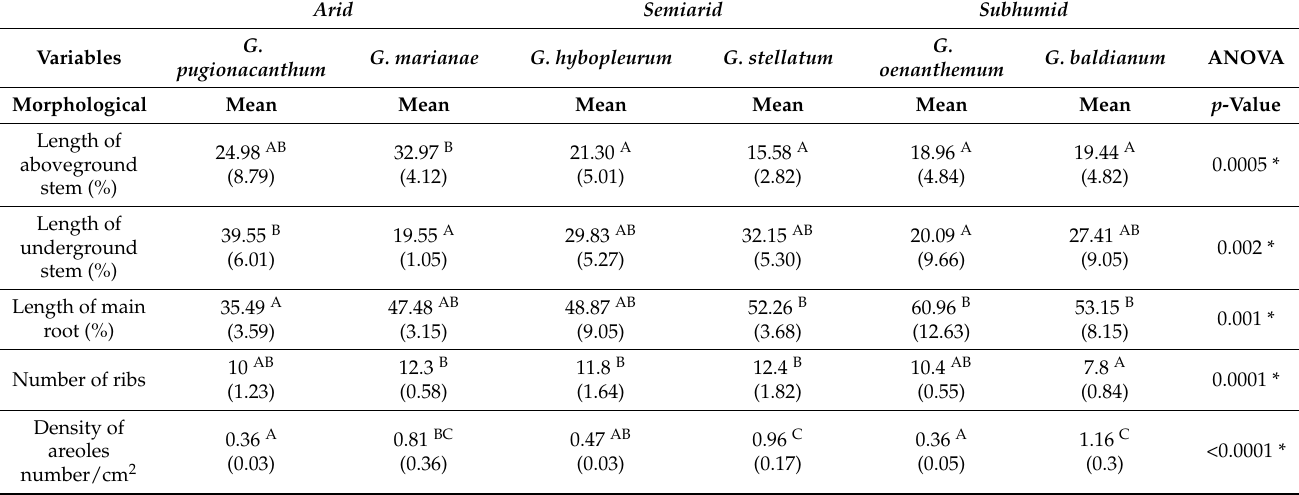
Table 1. Summary of all measured variables with mean and standard deviation (SD) for each species. * Significant differences ( p ≤ 0.05). Means with the same letter are not significantly